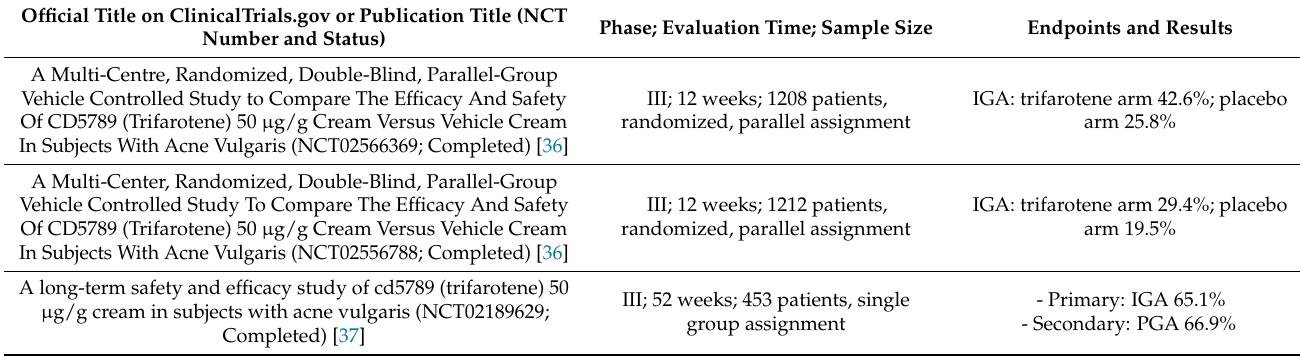
Table 2. Completed clinical trials with results evaluating trifarotene in acne vulgaris. Abbreviations: IGA: Investigator’s global assessment; PGA: Physician’s global